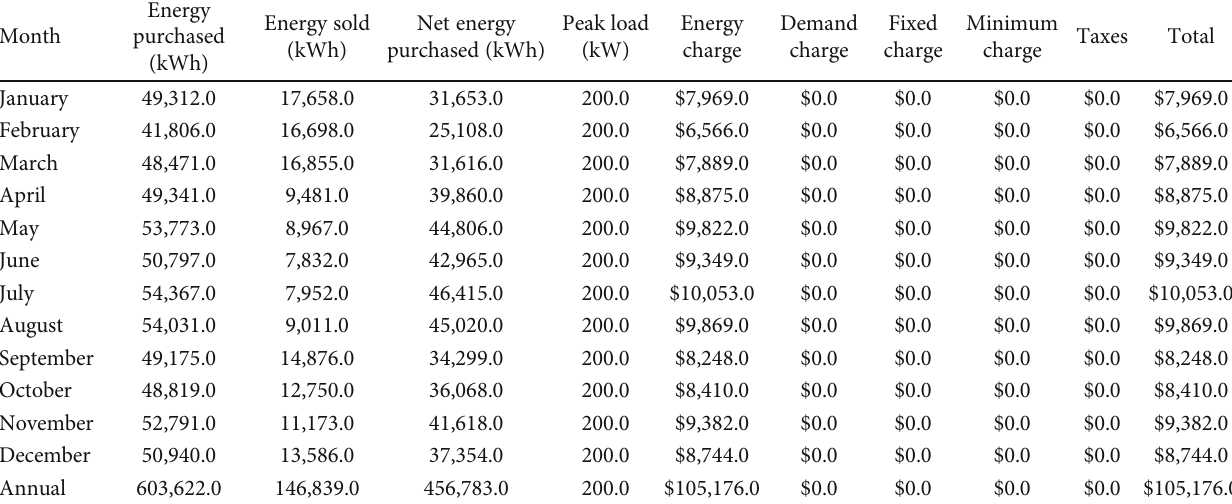
Table 10: Utility monthly summary — proposed system